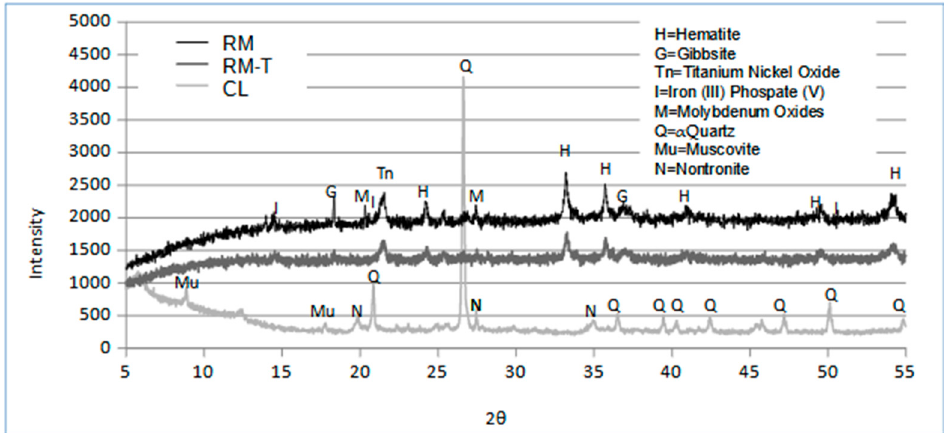
Figure 2. Mineralogical composition of red mud before and after the leaching process.